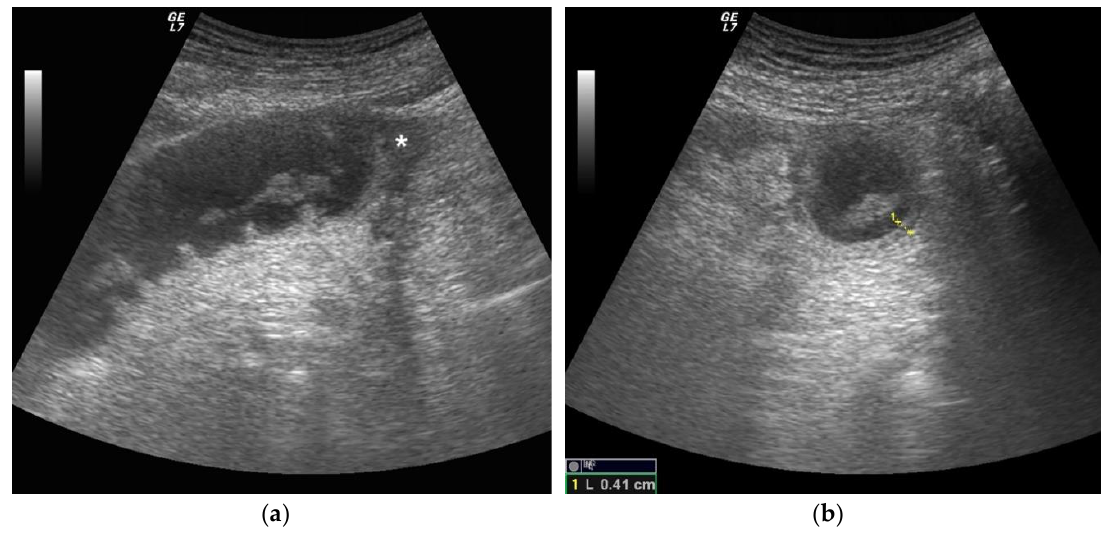
Figure 1. A 68-year-old female patient with previous abdominal surgery. Ultrasound image long ( a ) and axial ( b ) evaluation) of a fluid-filled dilated small bowel loop with hyperechogenic floating material. Bowel peristalsis was absent. Mild parietal and valvulae conniventes thickening were present. Free fluid between bowel loops was detected (*). At surgery, mechanical obstruction due to a bridle was evident after release of adhesion, the bowel loop pinks up, peristalsis recovered and resection was